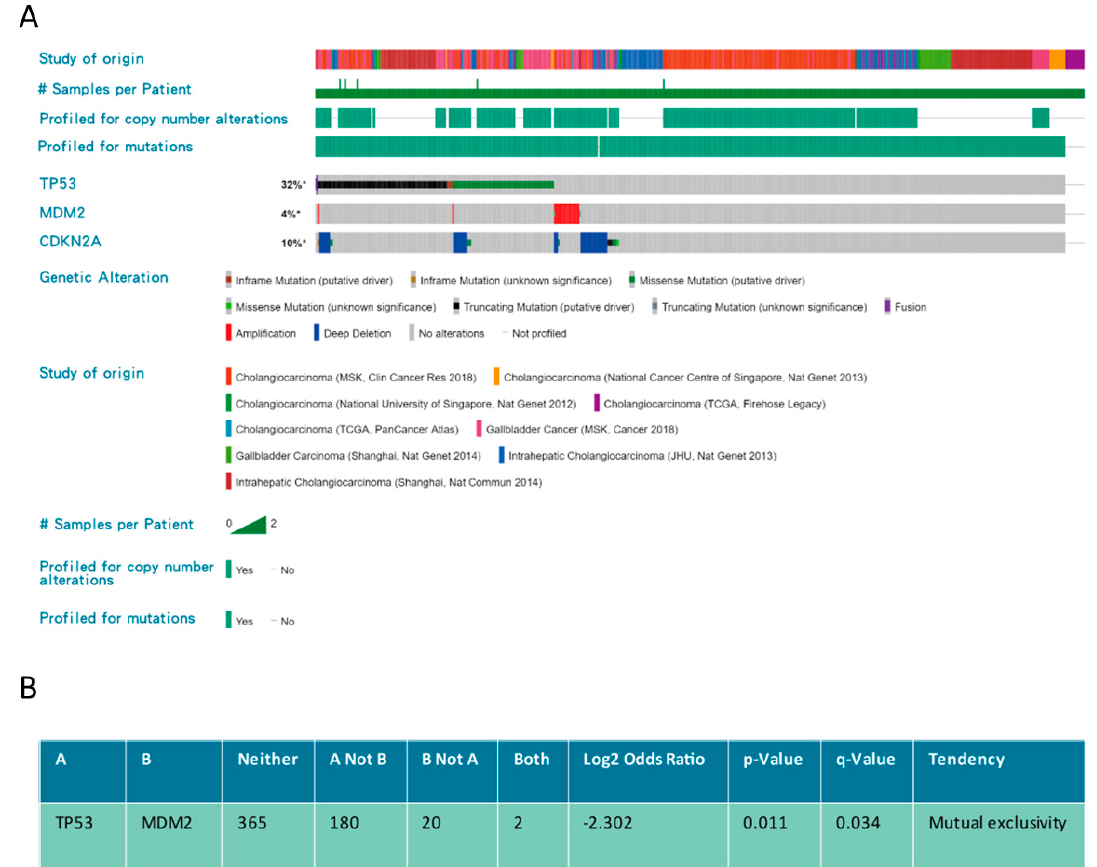
Figure 2. TP53 mutations in biliary tract cancers (BTCs). ( A ) Frequency of TP53 mutations in different studies. ( B ) The frequency of TP53 mutations in subtypes of BTC. ( C ) Collective results of available datasets of TP53 mutation in BTCs. ( D ) Lollipop plots for tumor TP53 mutations in BTC patients. TP53 mutations frequently occur in the DNA binding domain of p53 (red region). Black, green, pink and blue dots indicate truncating, missense, in-frame and other mutations, respectively. When different mutation types occur at a single position, the color of the circle indicates the most frequent mutation type. TAD, transactivation domain; TD, tetramerization domain. Data were